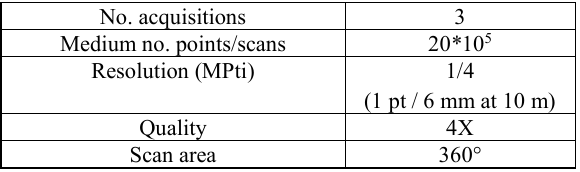
Table 2. Main parameters used for the laser acquisition